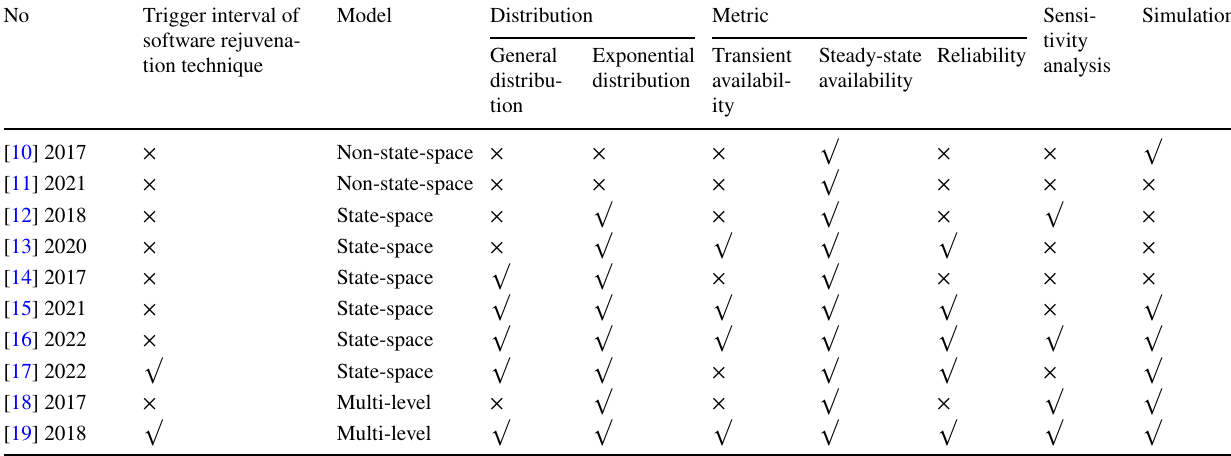
Table 1 Comparison of existing models discussed in Sect. 2 No Trigger interval of software rejuvena- tion